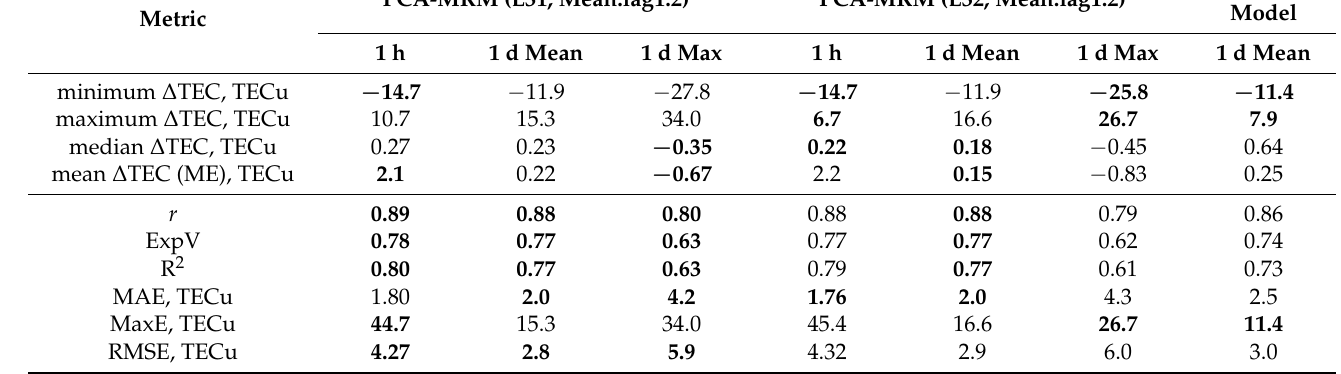
Table 2. Performance of the PCA-MRM (L##, mean.lag1.2) and the naïve models for the TEC series. Best scores of the models for each of the studied TEC series are in bold (1 h—columns 1 and 4, 1 d mean—columns 2, 5 and 7, and 1 d max—columns 3 and